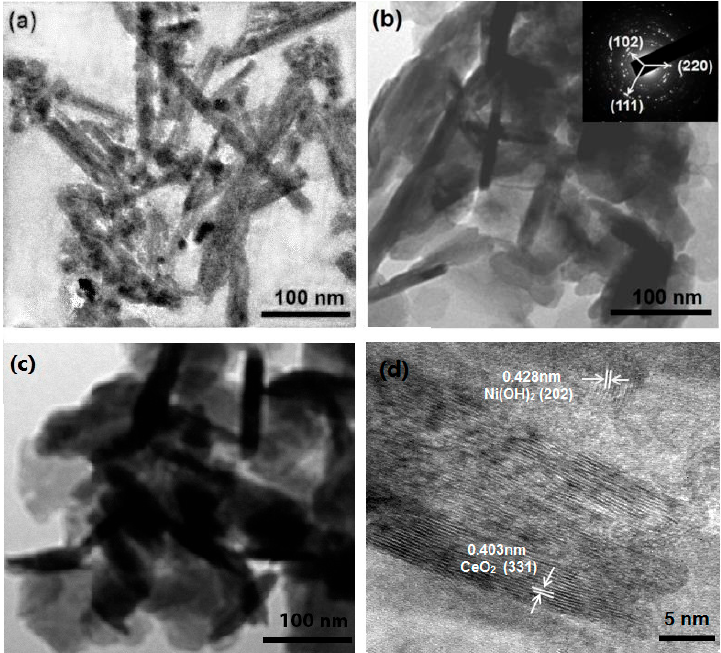
Figure 1. Transmission electron microscopy (TEM) images of ( a ) CeO 2 ; ( b ) CeO 2 /Ni(OH) 2 nanocomposite (Ce:Ni = 0.05:1); and ( c ) CeO 2 /Ni(OH) 2 nanocomposite (Ce:Ni = 0.5:1); ( d ) High-resolution TEM (HRTEM) image of CeO 2 /Ni(OH) 2 nanocomposite (Ce:Ni = 0.05:1). Inset is the SAED pattern.